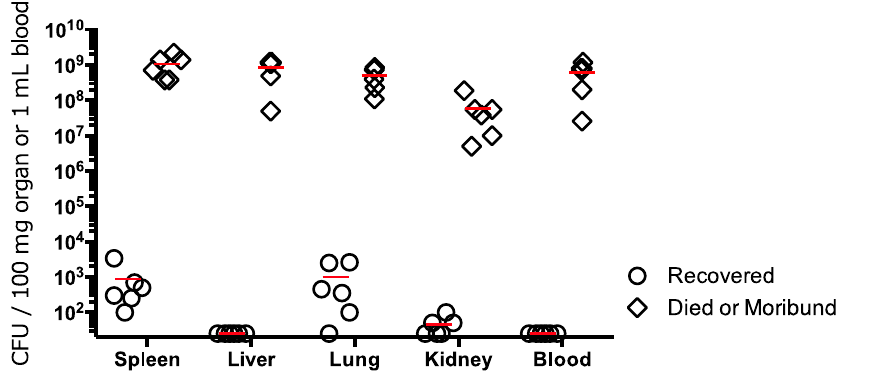
Figure 3. Bacterial burden in organs and blood of recovered and dead or moribund rats. Spleen, liver, lung, kidney, and blood were harvested from SD rats inoculated with 10 3 and 10 4 colony-forming units (CFUs) who survived to the end of the experiment period (days post inoculation (dpi: 21) ( n = 6) and dead or moribund SD rats inoculated with 10 6 and 10 7 CFUs (dpi: 2 or 3) ( n = 6). The mean bacterial burden is shown as a red-colored bar. Bacterial burden in all liver and blood samples of surviving rats were under the detection limit (<50 CFU).